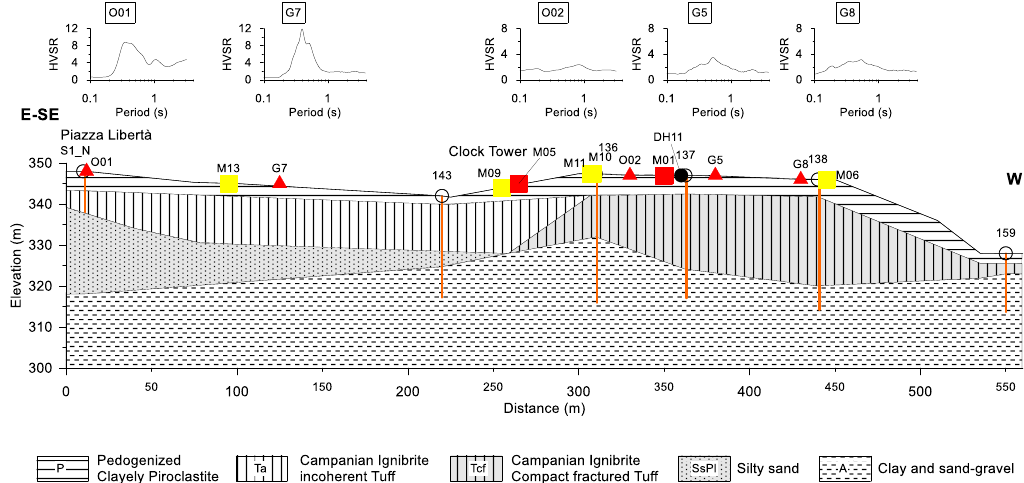
Figure 7. Lithostratigraphic cross-section along the trace indicated in Figure 6. The noise Horizontal to Vertical Spectral Ratio (HVSR) measurement sites with the HVSR curves are also reported. The orange vertical lines indicate the depth of each well.